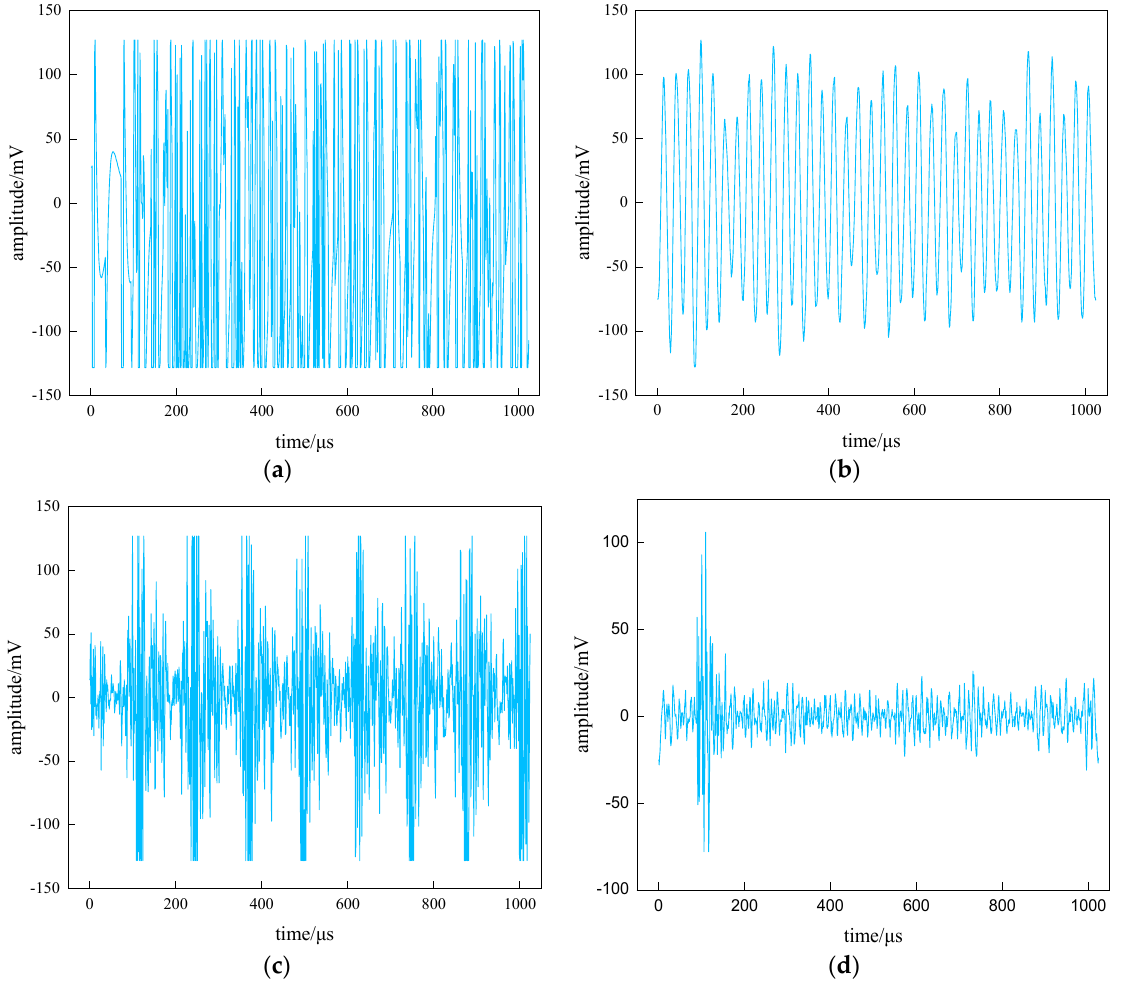
Figure 8. Four typical acoustic emission signal waveforms. ( a ) Blasting operation waveform, ( b ) shovel operation waveform, ( c ) rock drilling operation waveform and ( d ) surrounding rock body waveform.